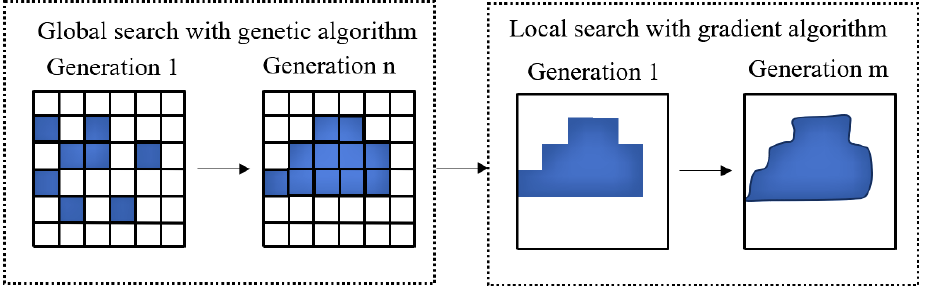
Figure 11. Example of an on/off TO algorithm where a genetic-based algorithm is combined with a gradient-based algorithm. The shape achieved with this algorithm is smoother. Figure is adapted from [8].